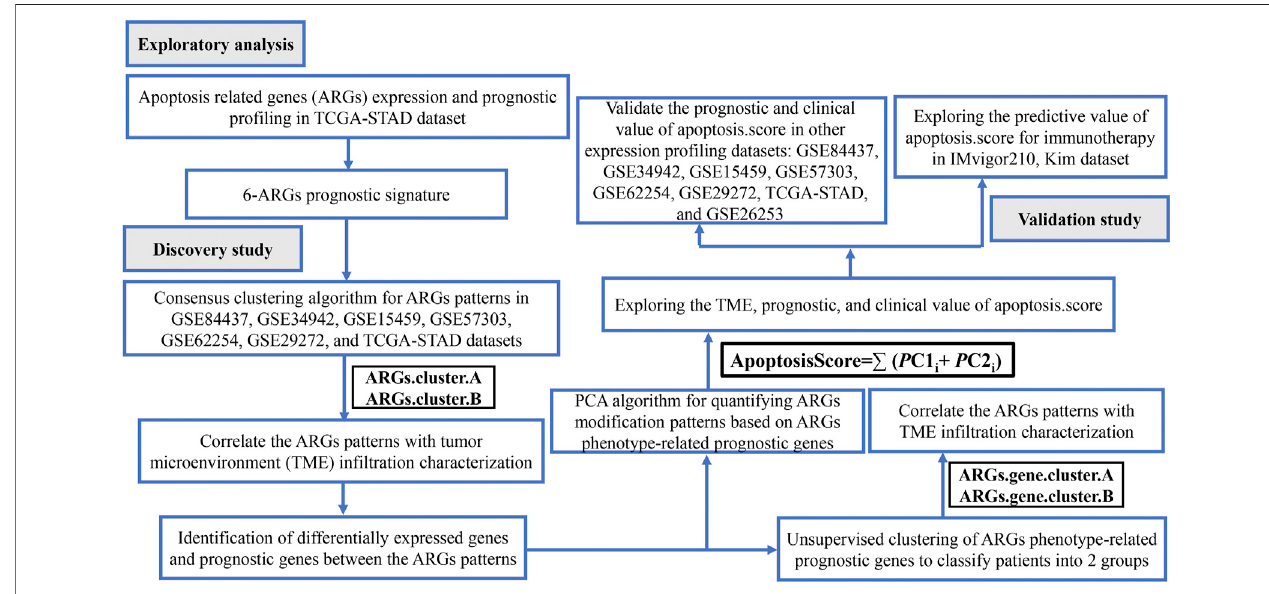
FIGURE 1 | Flow chart of the